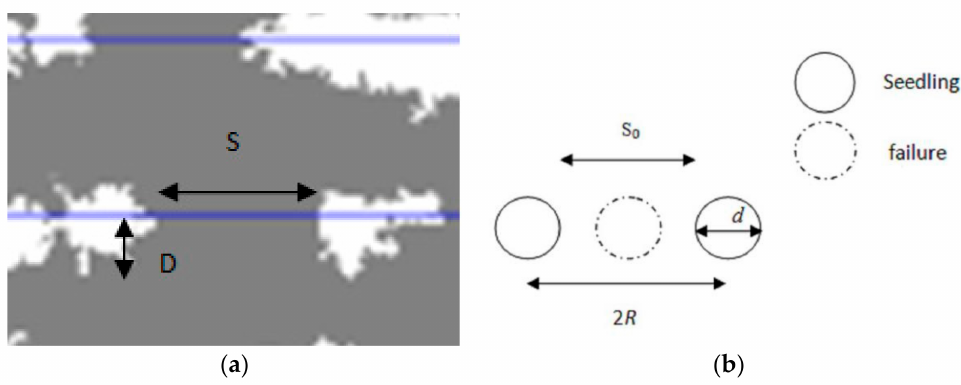
Figure 6. Schematic diagrams for the detection of failures: ( a ) detection of failures; ( b ) threshold S 0